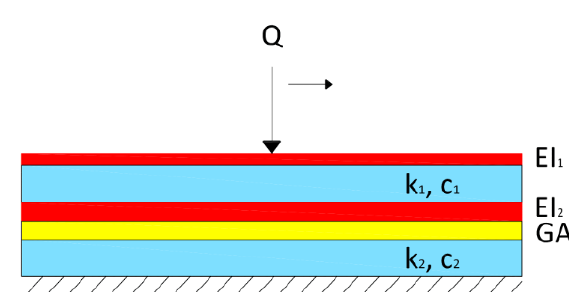
Figure 1. Schematic of the two-layer model on Paster- nak